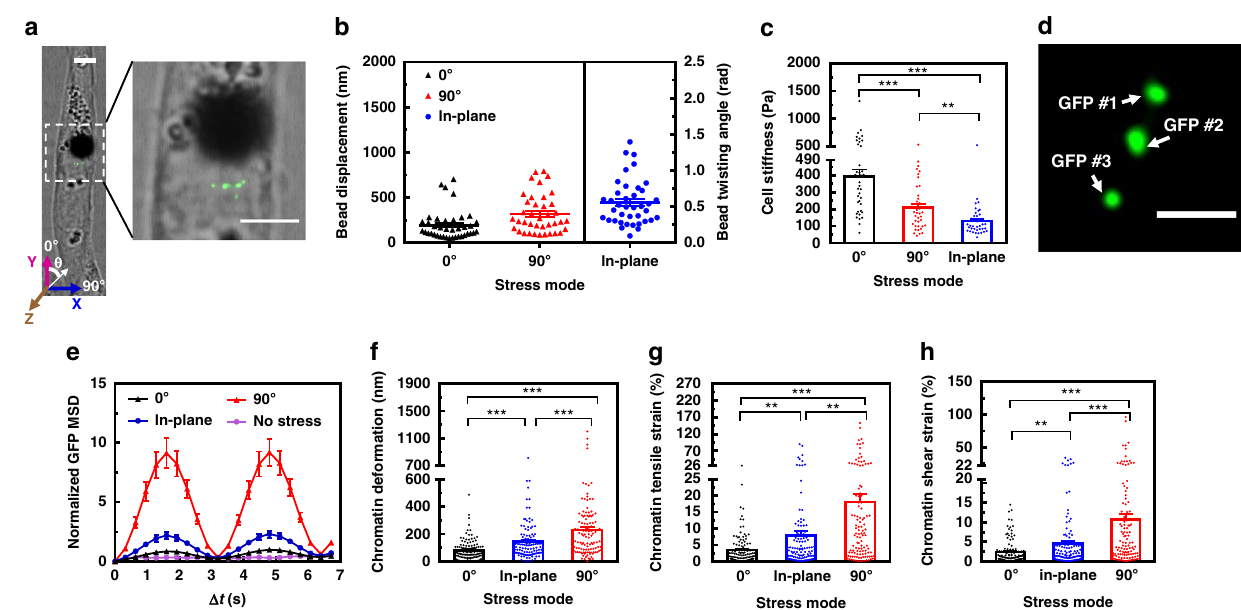
Fig. 2 Mechanical anisotropy of the cell and of the chromatin induced by different force modes. a A representative image of adherent and elongated CHO (Chinese hamster ovary) cell with the GFP labeled chromatin domain (green dots; see the enlarged image within the dashed white lines). A 4- μ m RGD-coated ferromagnetic bead (the solid black ball) was attached to the cell surface via integrins. Theta represents the angle of bead rolling direction with respect to the long axis of the cell (this notation applies to all cells in all fi gures). The bead and GFP spots in the white box were enlarged and shown on the right. Scale bar, 3 μ m. The in-plane ( X – Y plane) rotation has a direction along the Z -axis and the two out-of-plane rotations have directions along the X - and Y -axes, using the right-hand rule (see Fig. 1). b Peak 2D displacements of the center of the magnetic bead in the X – Y plane at stress angles 0° or 90° for the out-of-plane stress mode or the peak bead twisting angles for the in-plane stress mode in the same cell. In all stress modes, the peak amplitudes of the sinusoidal magnetic fi elds were maintained at 15 Pa and 0.3 Hz. Each triangle or dot represents one cell. c Cell stiffness computed with different stress modes. P = 0.0079 between 90° and in-plane stress modes; P < 0.001 between 0° and 90°, 0° and in-plane stress modes. d Fluorescent image of the three GFP spots in the same chromatin of a representative cell. Scale bar, 1 μ m. e Normalized mean squared displacement (MSD) of all individual GFP spots when the stress (15 Pa at 0.3 Hz) was applied at 0° or 90° or in-plane mode. No stress data represent the spontaneous GFR spots movements in the absence of force application. f Chromatin deformation (i.e., changes of distances between any two GFP spots in the same chromatin domain) depends on stress modes. P < 0.001 between each different stress modes. g Tensile strains of the chromatin were computed from chromatin deformation 21 . P = 0.0055 between 0° and in-plane stress modes; P = 0.0017 between in-plane and 90° stress modes; P < 0.001 between 0° and 90° stress modes. h Shear strains were computed from the same chromatin deformation. P = 0.00701 between 0° and in-plane stress modes; P < 0.001 between in-plane and 90° and 0° and 90° stress modes. For b , c , and e – h , mean ± s.e.m.; n = 39 cells, 29 independent experiments; ** P < 0.01; *** P < 0.001. P values were calculated and corrected using two-tailed Student ’ s t -test and Bonferroni correction. Source data are provided as a Source data fi